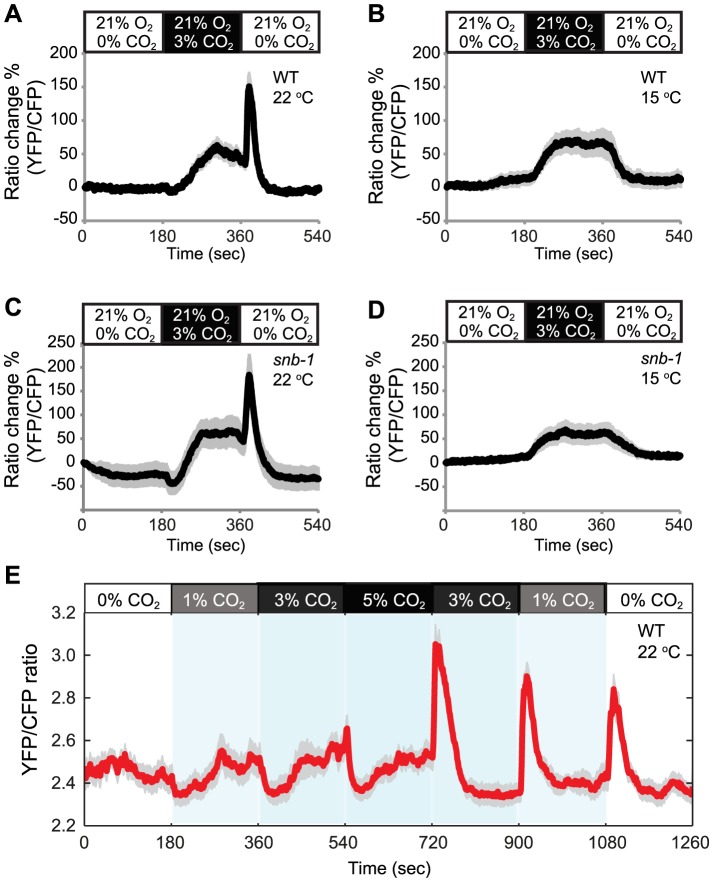
Acclimation temperature alters CO2-evoked Ca2+ responses in AFD neurons.In animals cultivated at 22°C a rise and fall in CO2 evokes a complex Ca2+ response in AFD neurons (A). Ca2+ initially falls when CO2 begins to increase, then rises. When CO2 levels fall, there is a Ca2+ spike. By contrast, animals cultivated at 15°C show a simple response to the same stimulus (B). C–D The effect of acclimation temperature on CO2-evoked Ca2+ responses in AFD neurons is unaltered in snb-1 mutants defective in synaptobrevin. E. Ca2+ responses evoked in AFD by a 0%–1%–3%–5%–3%–1%–0% CO2 stimulus train in animals acclimated to 22°C. Shading highlights switch times. Acclimation temperature is shown for each panel under genotype.